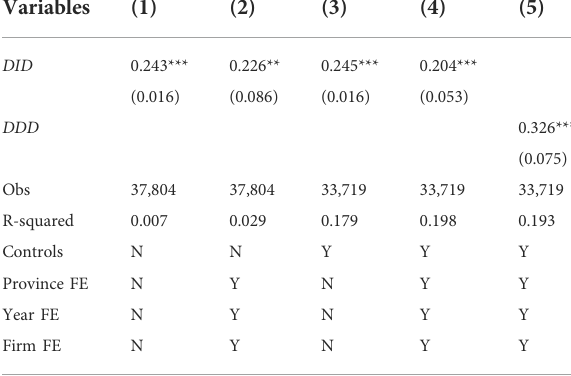
TABLE 2 Baseline regression